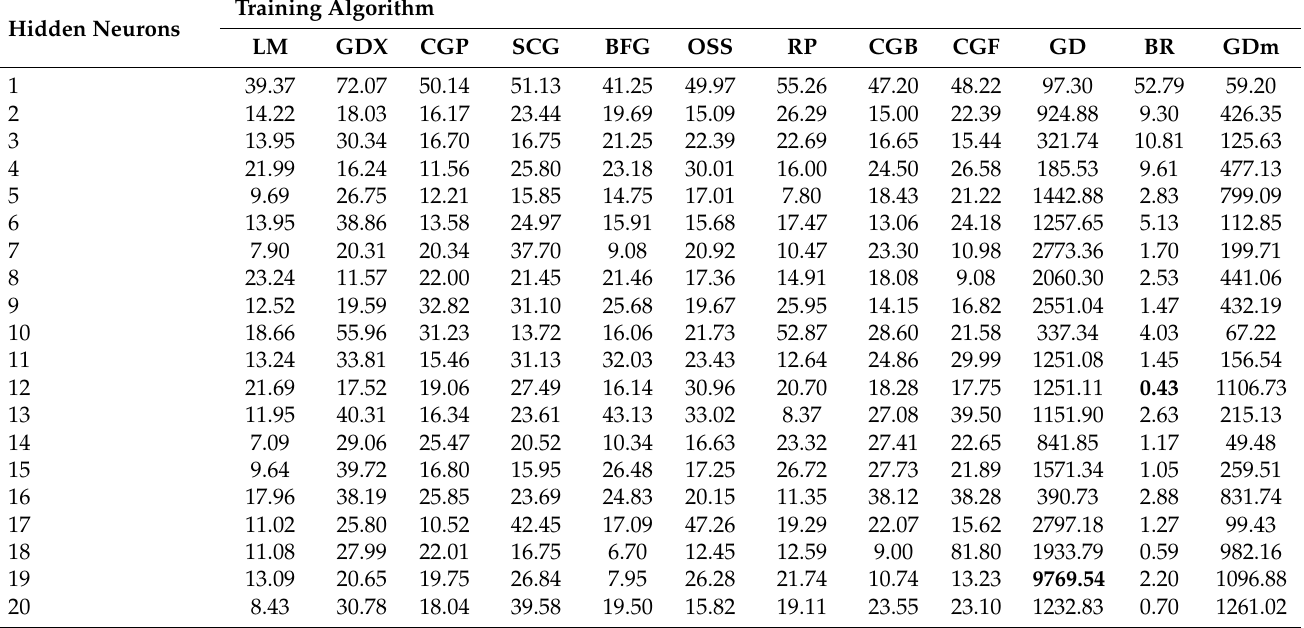
Table A10. MSE for COD removal (%) for different training algorithms at different number of hidden